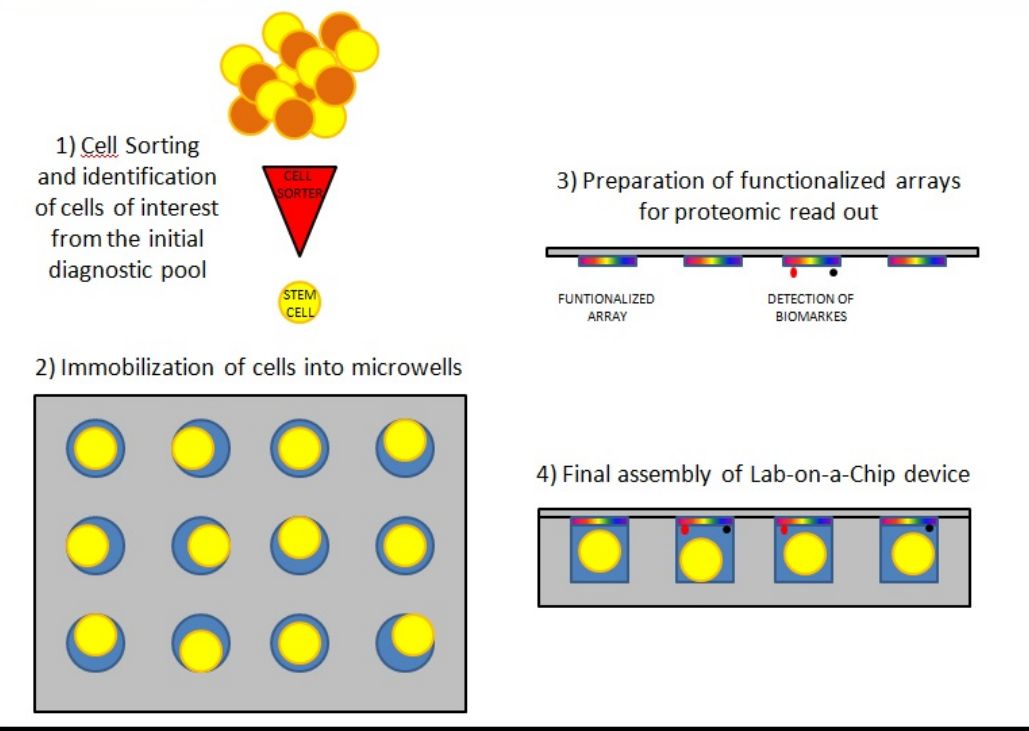
Figure 1. Schematic assembly of a lab ‐ on ‐ a ‐ chip device. The initial cell sorting allows for the identification of relevant cells, such as cancer stem cells (CSCs), thanks to the recognition of superficial antigens; following immobilization of those cells into microwells, the step of biomarkers identification is obtained through functionalized arrays positioned on top of each microwells.